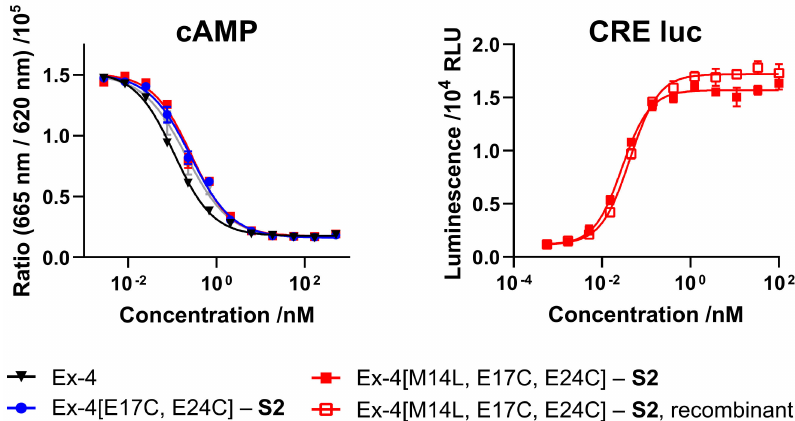
Figure 6. Dose-response curves for chemically synthesized and semisynthetic GLP-1R agonists in intracellular cAMP assay or CRE luciferase reporter assay (see Materials and Methods section, EC 50 values shown in Table 3). Table 3. Activity of chemically-synthesized and recombinantly expressed (semisynthetic) GLP-1R agonist sequences, with / without M14L mutation, stapled with S2 (CRE luciferase reporter assay and intracellular cAMP assay, see Materials and Methods section). GLP-1R EC 50 / Peptide Origin Staple